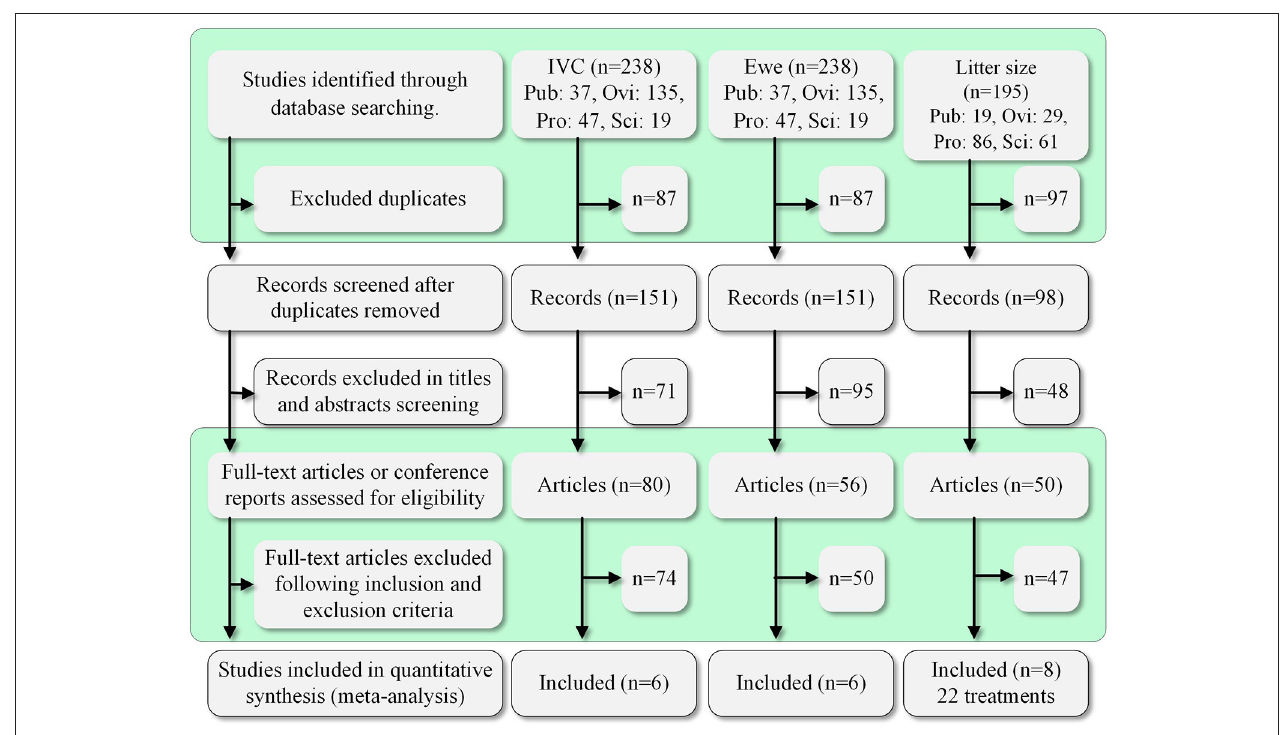
FIGURE 1 | Summary of the study selection process. Pub, PubMed; Ovi, Ovid; Pro, ProQuest; Sci,